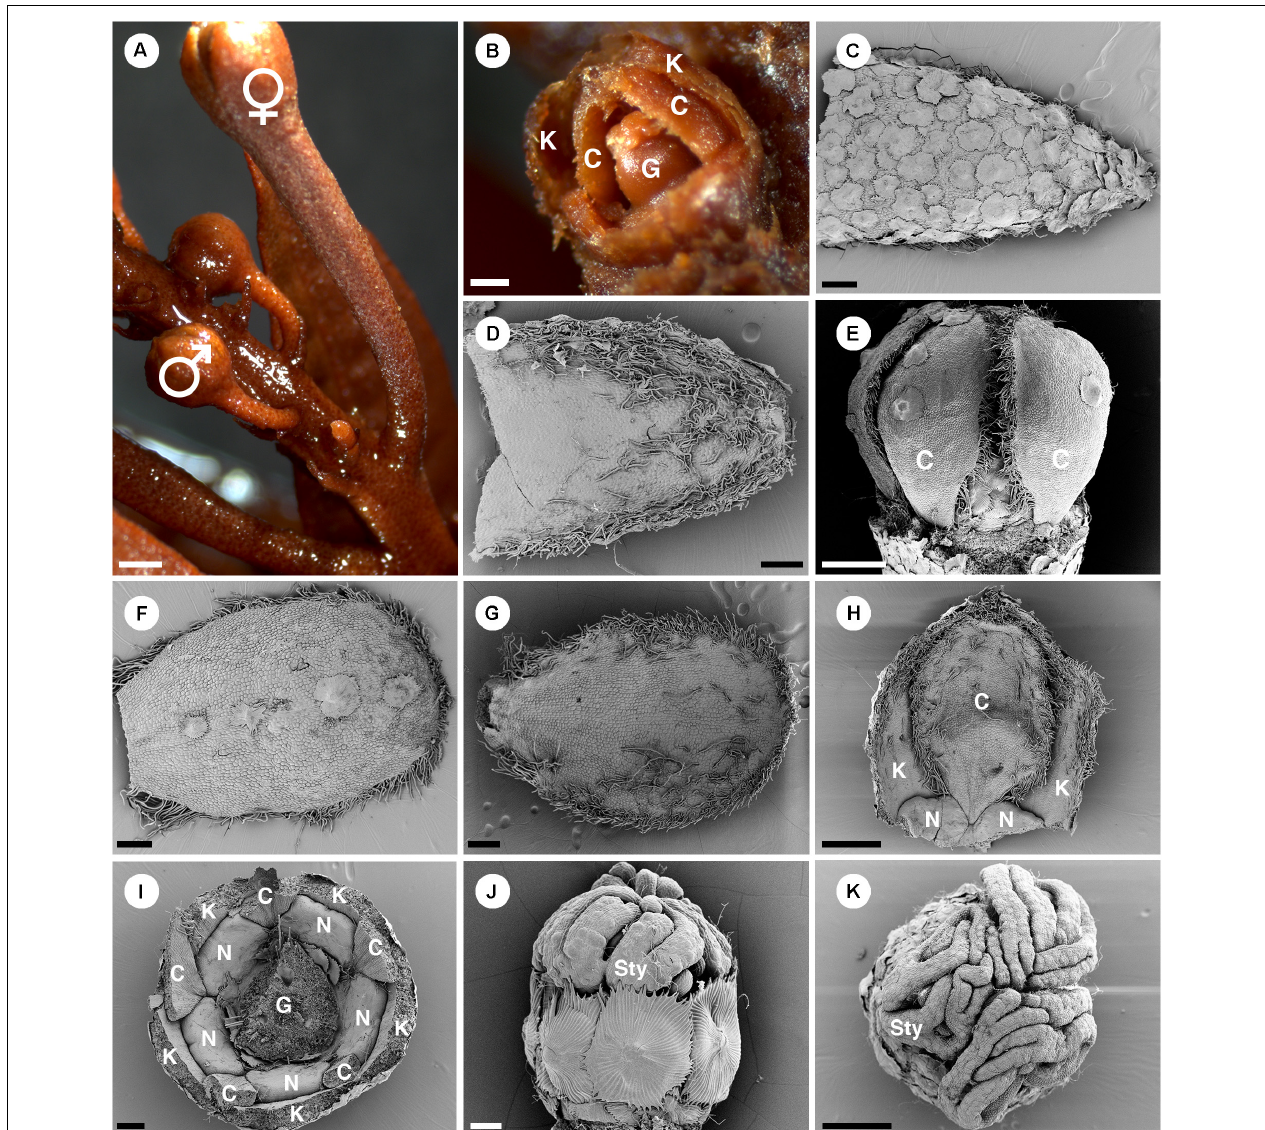
FIGURE 11 | Morphology of pistillate flowers of Croton schiedeanus . (A) An inflorescence with a pistillate flower on the lower part and many proximal staminate flower buds. The pistillate flower has a longer and thicker pedicel than staminate flower buds. (B) A pistillate flower bud with some sepals removed. There are petals visible within. (C) Abaxial side of a sepal covered completely with lepidote trichomes. (D) Adaxial side of a sepal with simple and stellate trichomes present. (E) A pistillate flower bud which calyx and nectary glands removed. Petals show a narrow base. (F) Abaxial side of a petal. There are few lepidote trichomes along the midrib. The margin is fimbriate. (G) Adaxial side of a petal. The fimbriate margin consists of crushed stellate trichomes and densely packed simple trichomes. (H) A petal is arranged alternating with sepals and nectaries. Note, the base looks like a claw due to the influence of the nectary expansion during development. (I) A flower bud in which the ovary and part of the perianth were removed. There are five bilobed nectary glands located around the ovary. (J) Ovary with surface covered with lepidote trichomes. There are styles on top of it. (K) Styles on top of an ovary with multifid stigmatic tips. K, sepal; C, petal; G, ovary; N, nectary; Sty, style. Scale bars: (A) = 1,000 µ m; (B–D,F,G,I) = 200 µ m; (E,H,K) = 500 µ m; (J) = 100 µ